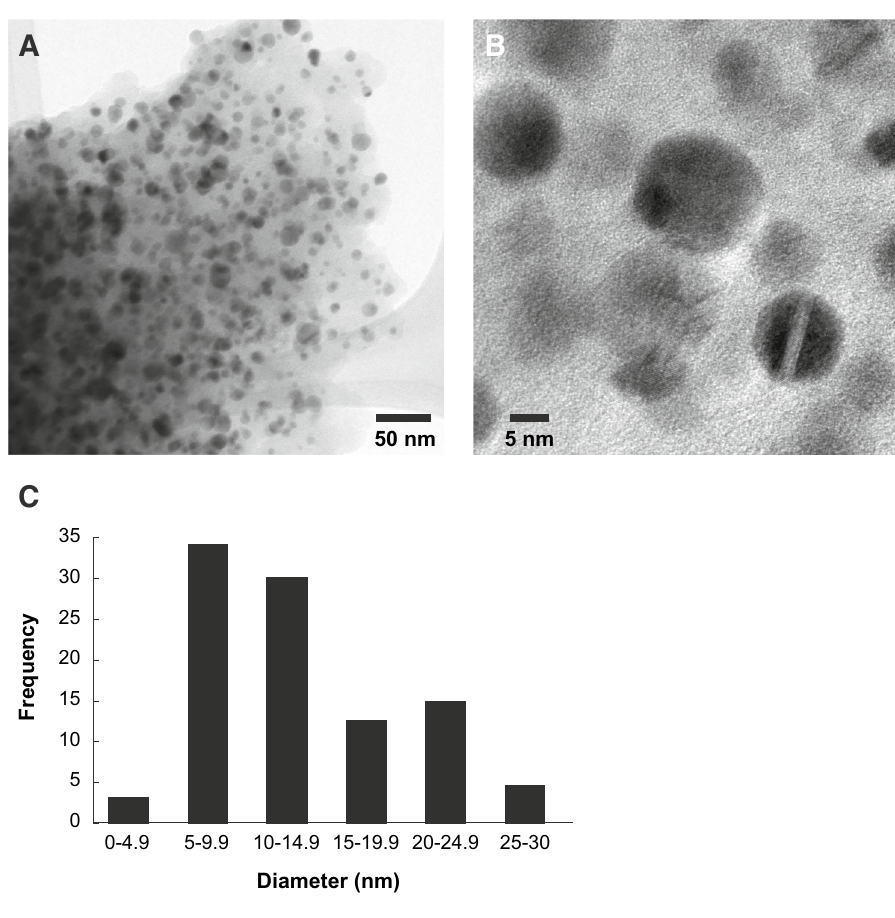
Figure 3. Transmission Electron Microscopy (TEM) characterization of Ag–Fe bimetallic nanoparticles synthesized using an aqueous extract from leaves of Gardenia jasminoides ( A ) Low magnitude TEM ( B )